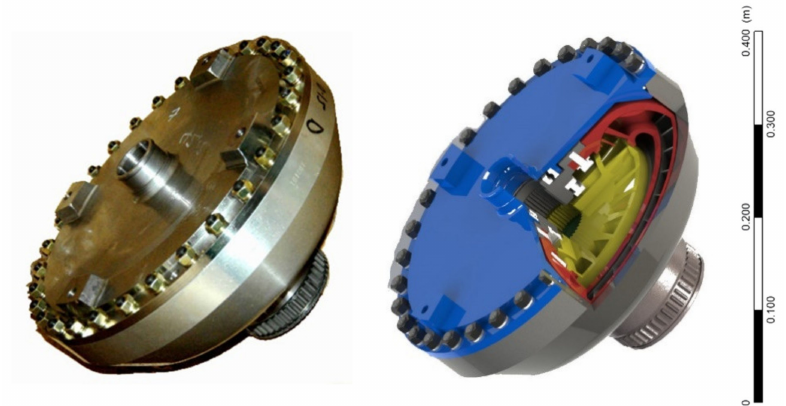
Figure 1. A basic model of hydraulic torque converter